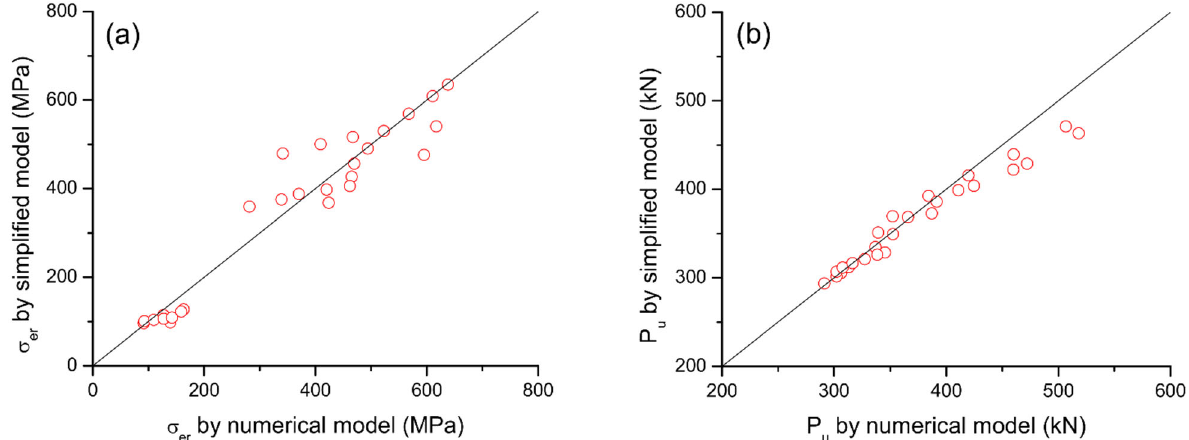
Figure 16. Correlation of results calculated by simplified and numerical models. ( a ) ultimate stress in externa reinforcement; ( b ) ultimate load.